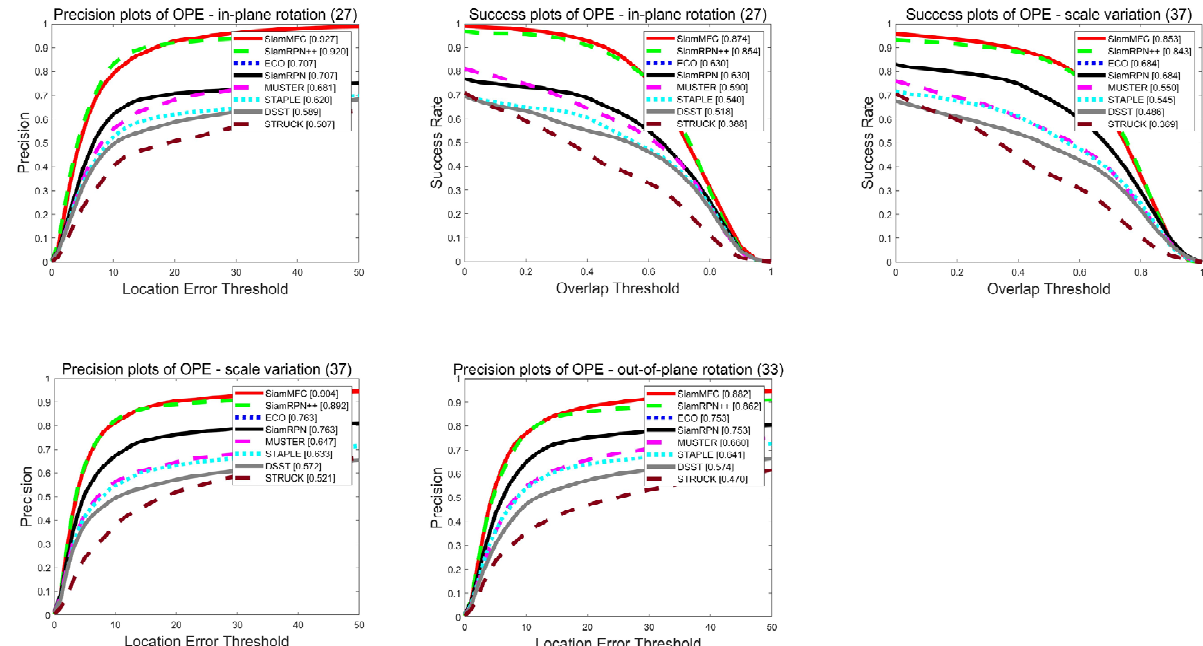
Figure 5. Performance comparison plot of eight trackers in different challenges of